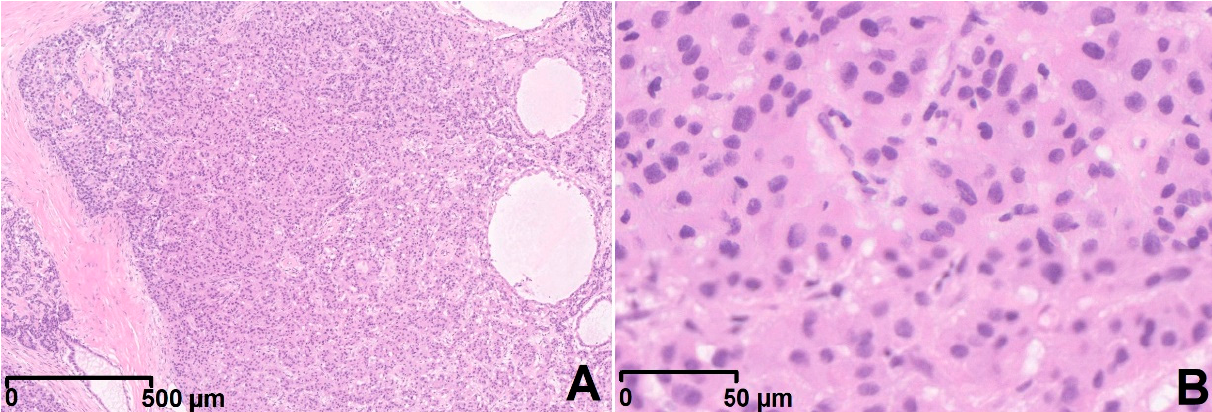
Figure 1. Overview of an acinar cell carcinoma with typical high cellularity and scant fibrous stroma ( A , 2.5-fold magnification). In higher magnification ( B , 20-fold magnification), tumor cells are presenting a granular eosinophilic cytoplasm and uniform nuclei (hematoxylin and eosin staining).